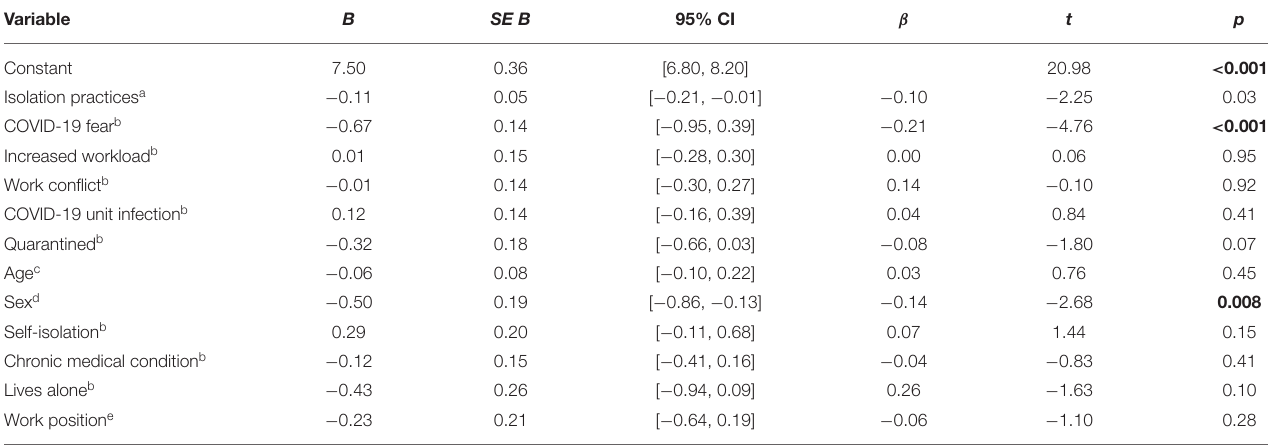
TABLE 12 | Multiple linear regression analysis for worker variables predicting CD-RISC-2 resilience score.